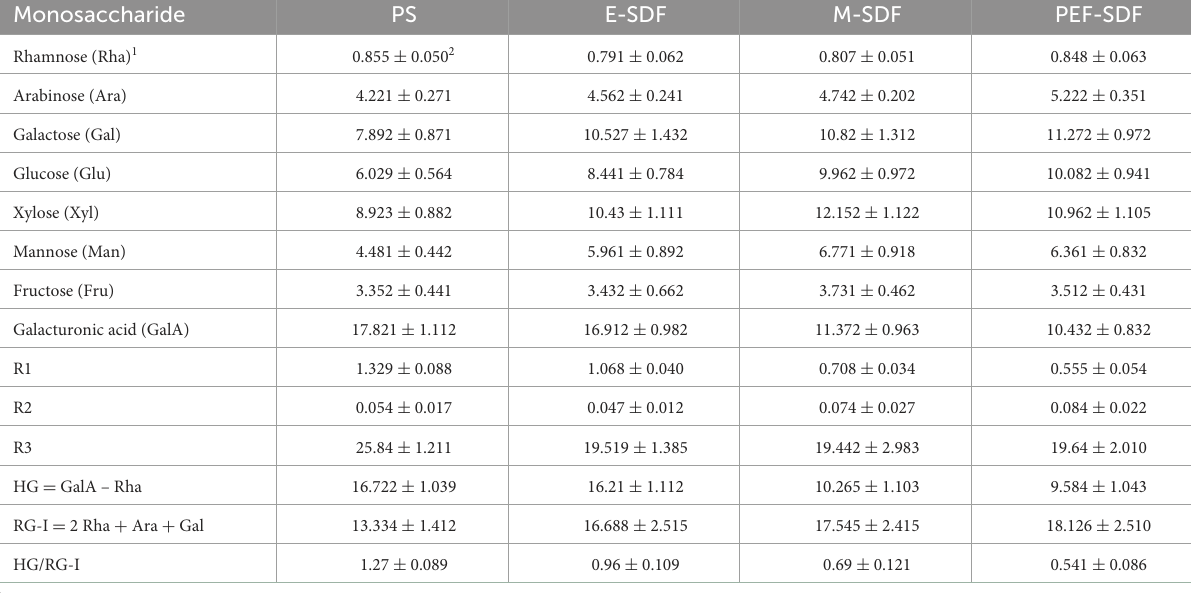
TABLE 4 The monosaccharide composition of PS, E-SDF, W-SDF, and PEF-SDF. Monosaccharide PS E-SDF M-SDF